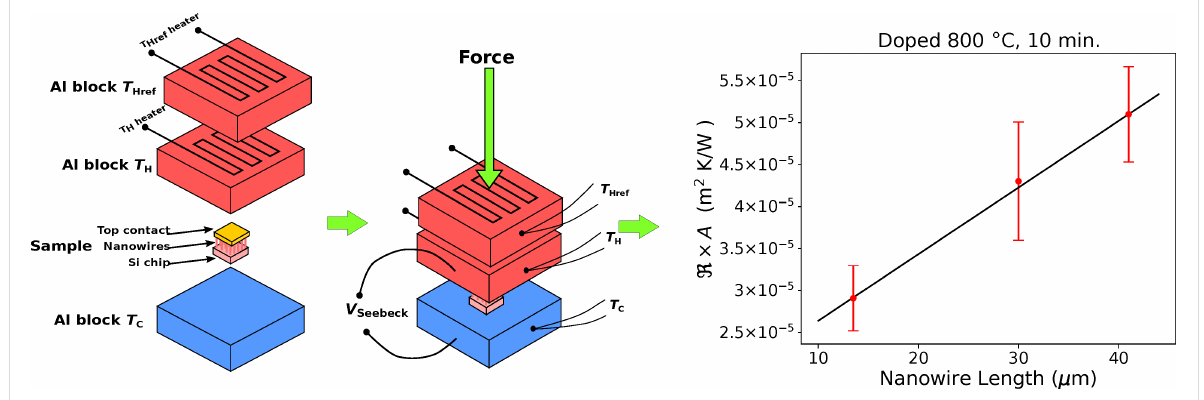
Figure 2: Left: sketch of the measurement apparatus. Right: thermal resistance of several samples as a function of the nanowire length (doping at 800 °C for 10 min).